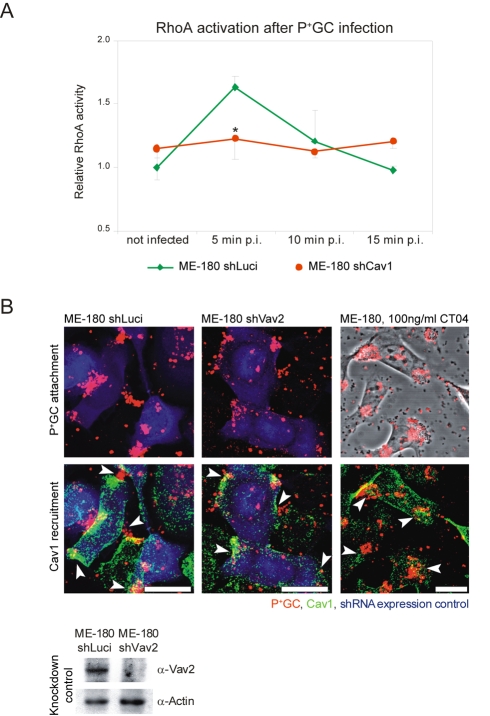
Vav2 and RhoA act as downstream signaling partners of Cav1 during P+GC infection.(A) RhoA activation after P+GC infection depends on Cav1 expression. Levels of the active, GTP-bound state of RhoA are compared between ME-180 shCav1 knockdown cells and ME-180 shLuciferase control cells during an infection time-course. Data are mean ± standard deviation of triplicate wells after normalizing protein levels. RhoA activity was normalized to uninfected ME-180 shLuciferase cells. (B) Cav1 recruitment does not depend on Vav2 expression or RhoA activation. Cav1 (green) recruitment to attached P+GC (red) is observed in ME-180 shLuciferase control cells (blue, upper left panels), ME-180 shVav2 knockdown cells (blue, upper middle panels), and Rho inhibitor CT04-treated ME-180 cells (upper right panels). Recruited Cav1 is indicated by arrows. Efficiency of Vav2 knockdown in ME-180 cells after lentiviral transduction of luciferase (control) or Vav2 shRNA constructs (lower panel). Scale bar: 20 µm. Images are representative of three independent experiments.